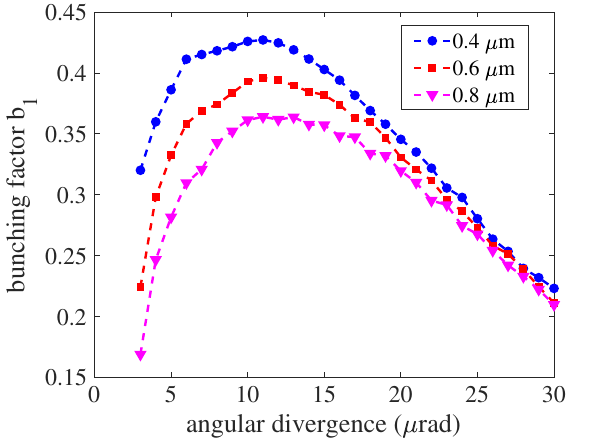
FIG. 6. Bunching factor for different frequency with the same beam